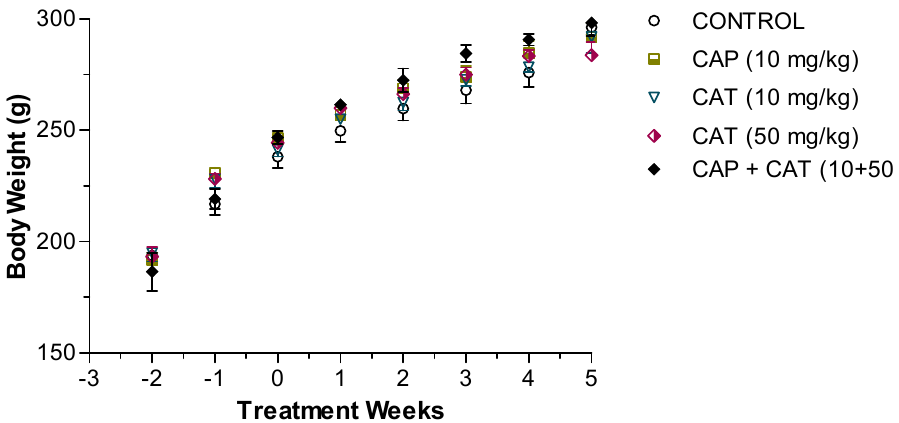
Figure 2. Age-related changes in body weight of male spontaneously hypertensive rats treated with vehicle (control), captopril (CAP), and catechin (CAT). Each point represents the mean ± SEM of six–nine animals.